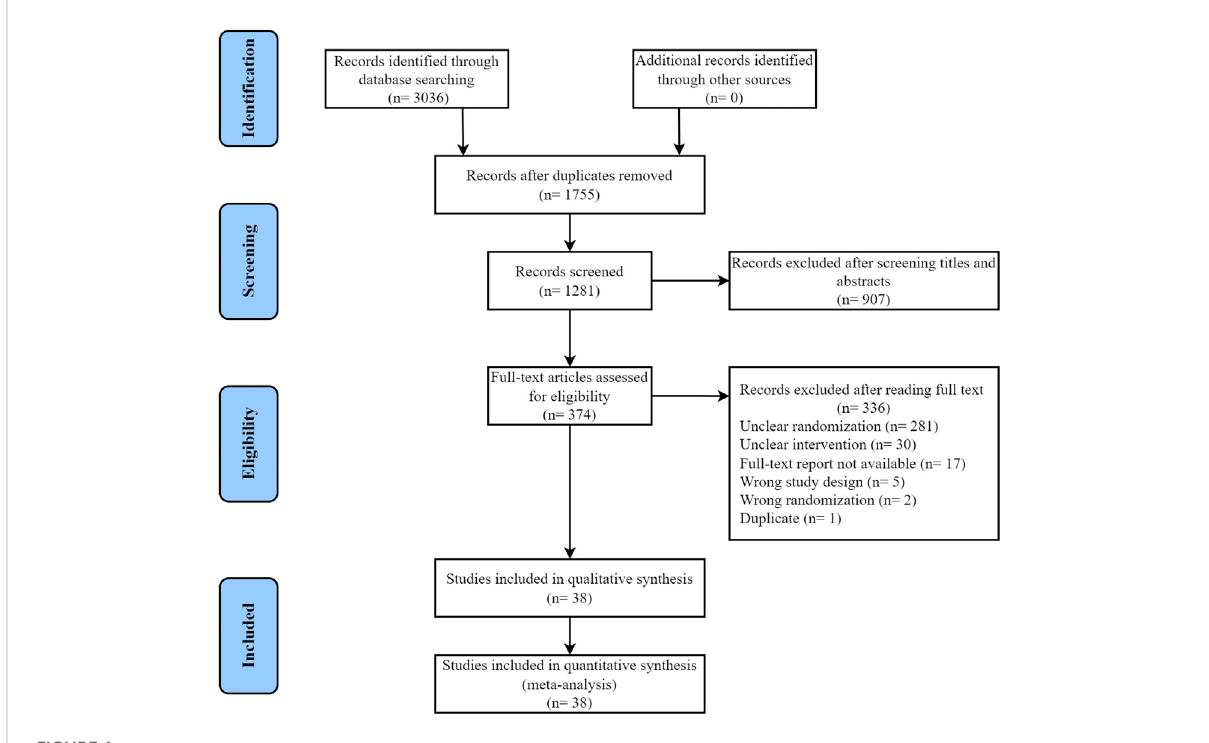
FIGURE 1 Flow diagram of study